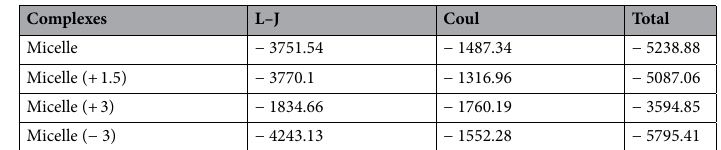
Table 1. The L–J, Coul and total interaction energies between PS-β-CD/PE-FE molecules in the investigated systems (all energy values are in kJ/mol).